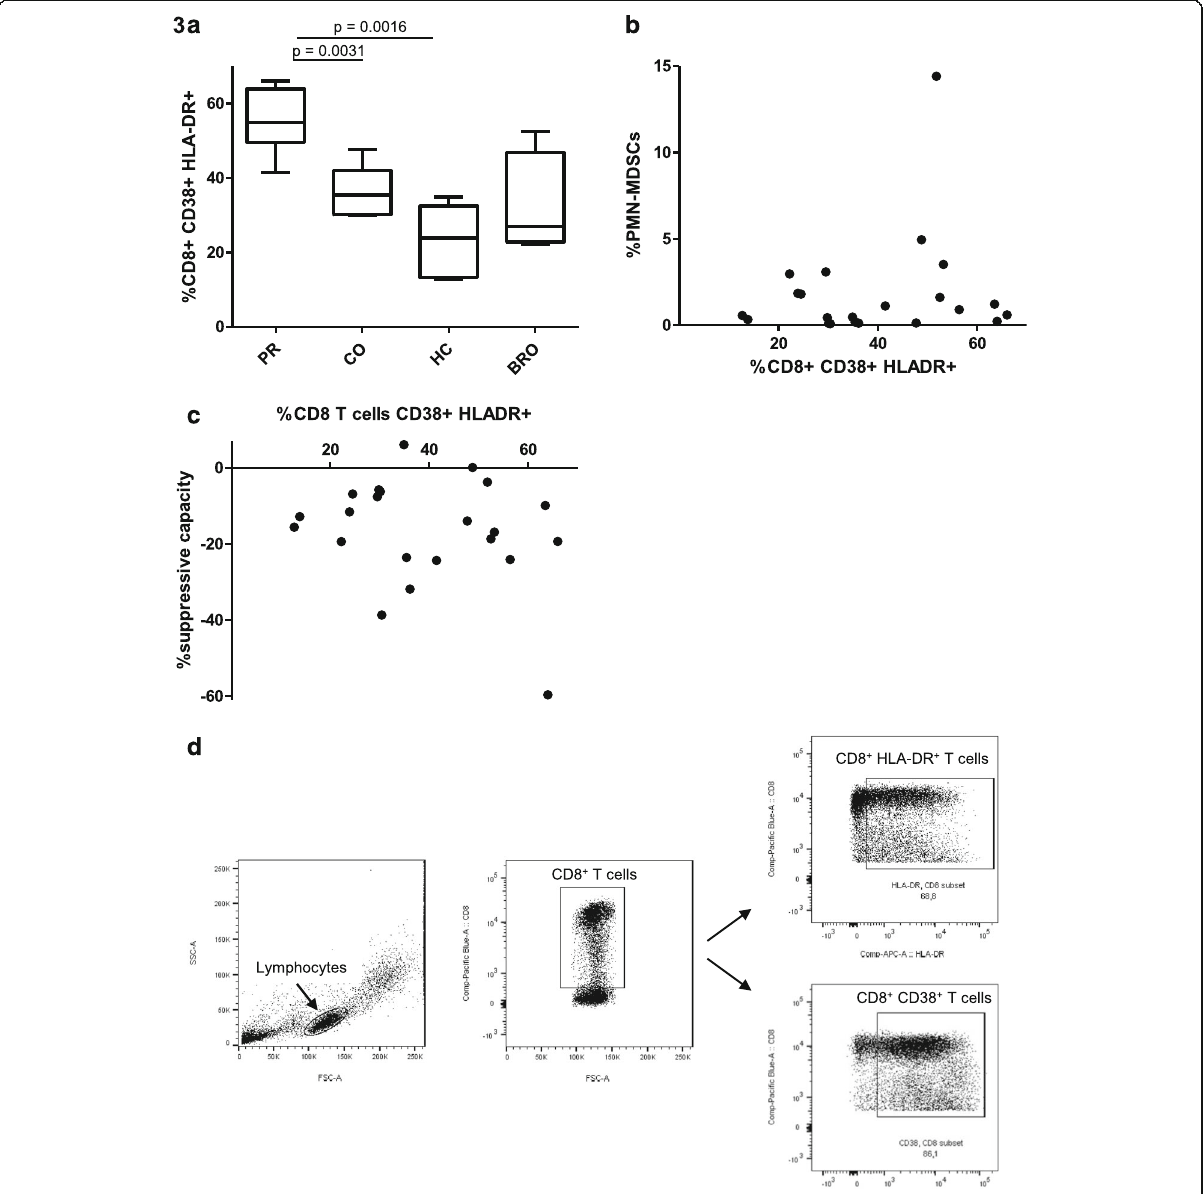
Fig. 3 Immune activation and correlation of CD8 + CD38 + HLA-DR + cells with frequencies and suppressive capacity of PMN-MDSCs. a Frequencies of CD8 T cells expressing CD38 and HLA-DR were significantly higher in progressors (PR) than in controllers (CO) ( p = 0.0031) and healthy controls ( p = 0.0016). b CD8 T cells expressing CD38 and HLA-DR do not correlate with PMN-MDSC frequencies (rho = 0.085, p = 0.71) ( b ) and suppressive capacity (rho = − 0.25, p = 0.27) ( c ) in all subjects. d Representative dot plots and gating strategies of activated CD8 T cells. The first panel shows the lymphocyte population. The CD8 positive cells are gated in the second panel (rectangular gate). Afterwards, CD8 T cells were gated on the markers HLA-DR and CD38. [all subjects: n = 22; PR: n = 8; CO: n = 5; HC: n = 5; BRO: n =